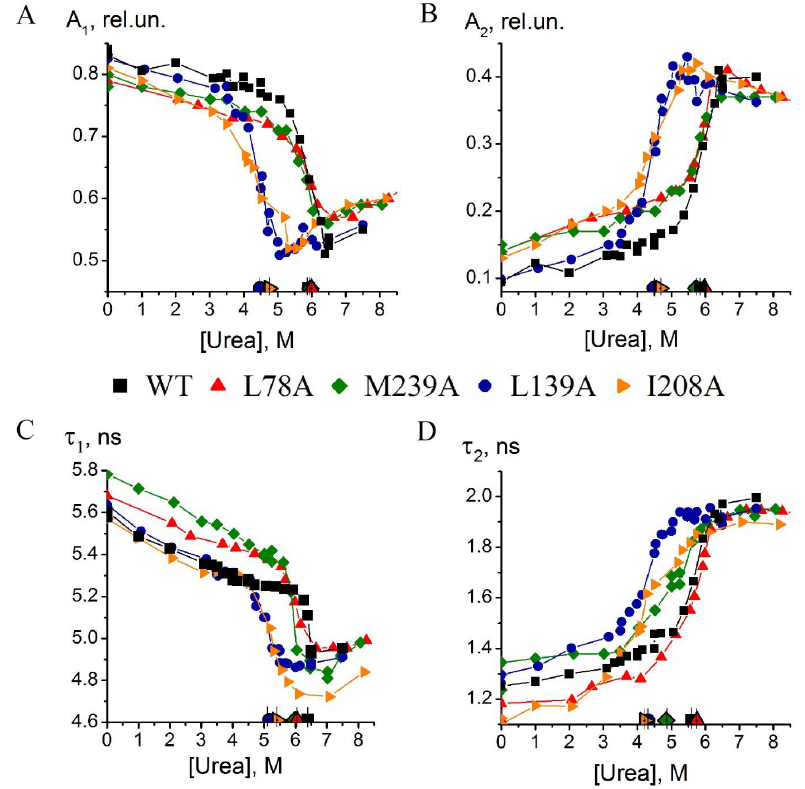
Figure 3. Dependencies of spectral contributions A 1 , A 2 ( A , B ) and lifetimes τ 1 , τ 2 ( C , D ) calculated from fluorescence decay curves on urea concentrations for carbonic anhydrase II solutions: wild-type (black), L78A (red), L139A (blue), I208A (orange), M239A (green). The solid line serves to guide the eyes. Markers with ticks near the abscissa axis refer to the apparent transition midpoints of the corresponding curves.